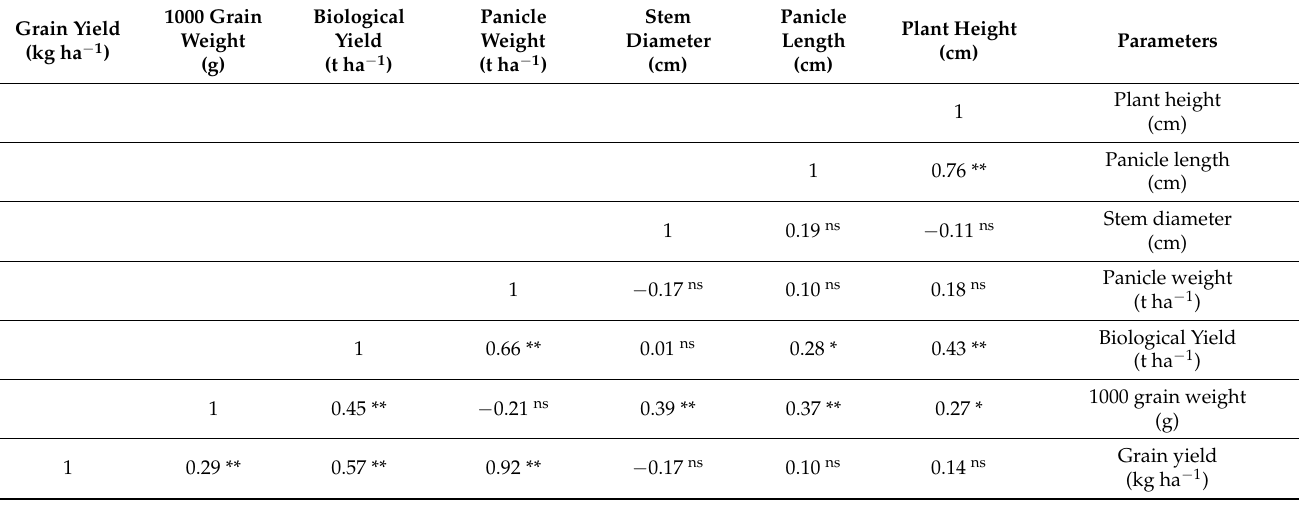
Table 2. Correlations between morphological characteristics, biological yield and grain yield in promising grain sorghum